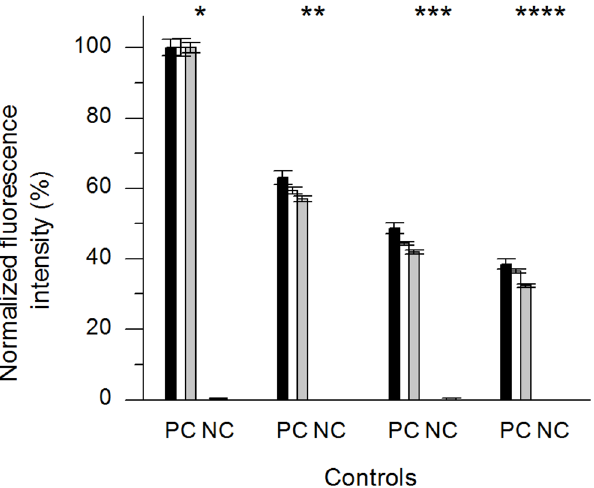
Fig 6. Controls for the repetitive replacement assay. As a positive control in the repetitive replacement assay, GFP-hCC was incubated at the same time as the second antigen in the first cycle of replacement and PBS only was used for the second to fourth cycles. We used hCC as the negative control. Four readouts were obtained, one after each replacement cycle. Each assay was performed in triplicate (error bars represent standard deviations). The background was subtracted from mean values and the resulting fluorescence was normalised to the positive control from the first readout and was plotted as a percentage. The assay was carried out three times (n = 1 – 3 indicated as black, white and grey bars). PC: CyDI-4/BSA/GFP-hCC, NC: CyDI-4/BSA/hCC, Asterisks indicate the first to fourth readouts.